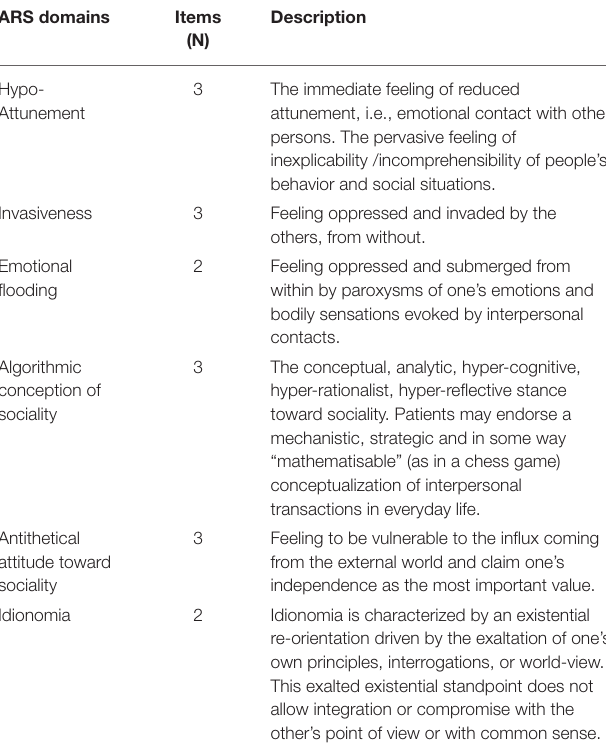
TABLE 1 | List and description of the ARS